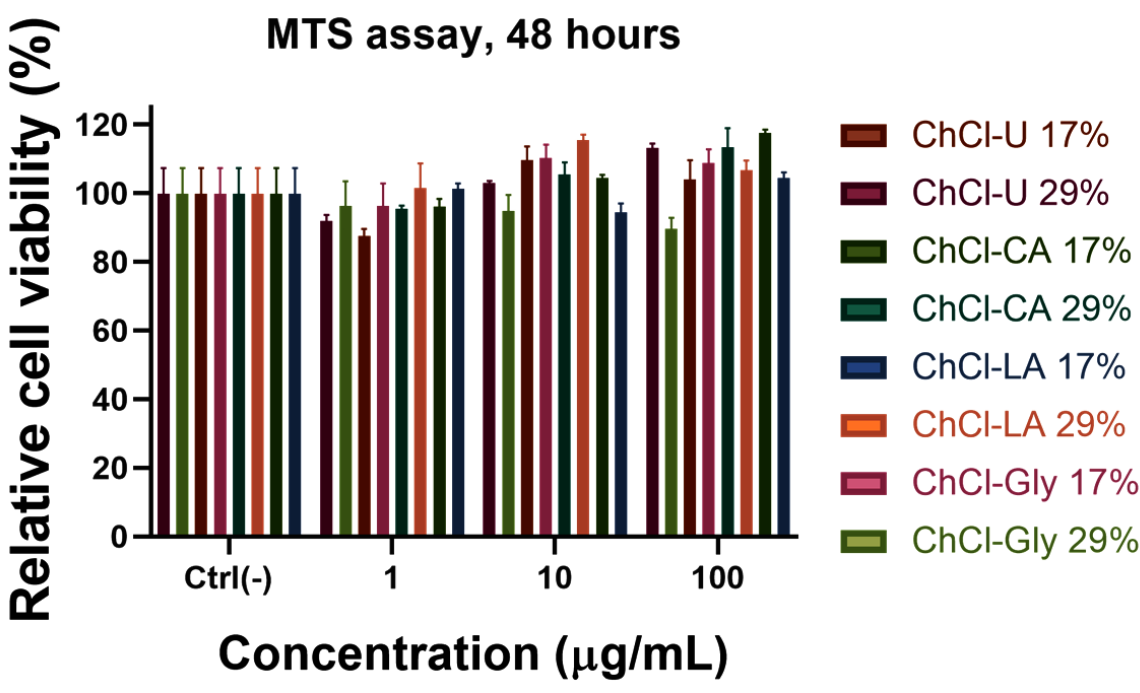
Figure 13. MTS assay on human gingival fibroblast of the prepared HPC-NADES gels.